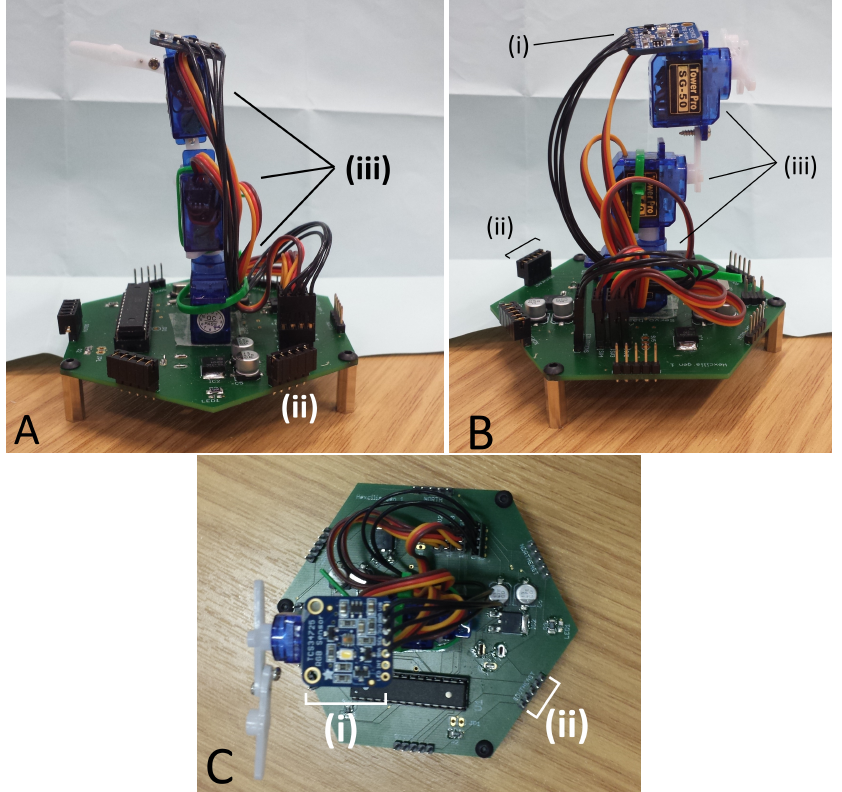
Figure 4. Three views (A,B and C) of an artificial cilia developed to mimic ciliary beating. (i) The color sensor; (ii) the local neighbor pins; (iii) servos mounted in